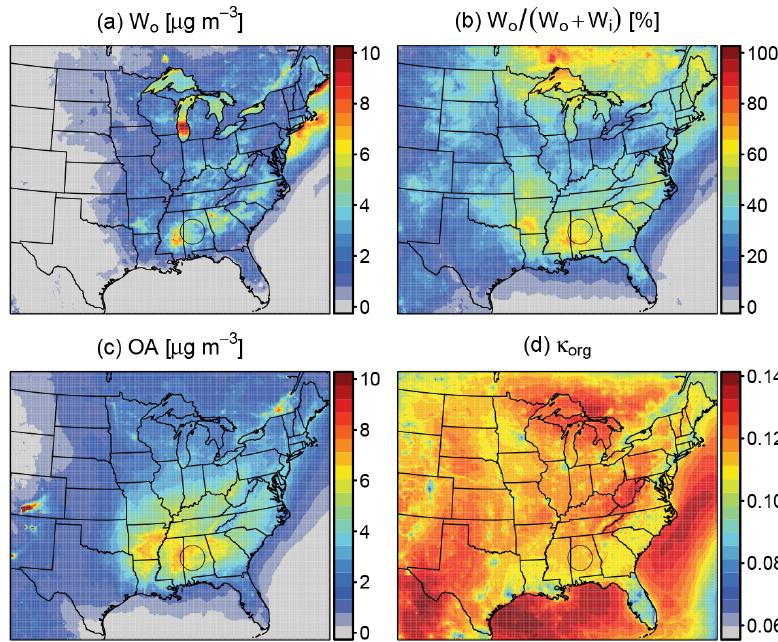
Figure 12. June 2013 mean predicted (a) aerosol water due to organic species, (b) contribution of organic water to total aerosol water, (c) total organic aerosol, and (d) hygroscopicity parameter for the γ (cid:54)= 1 simulation.